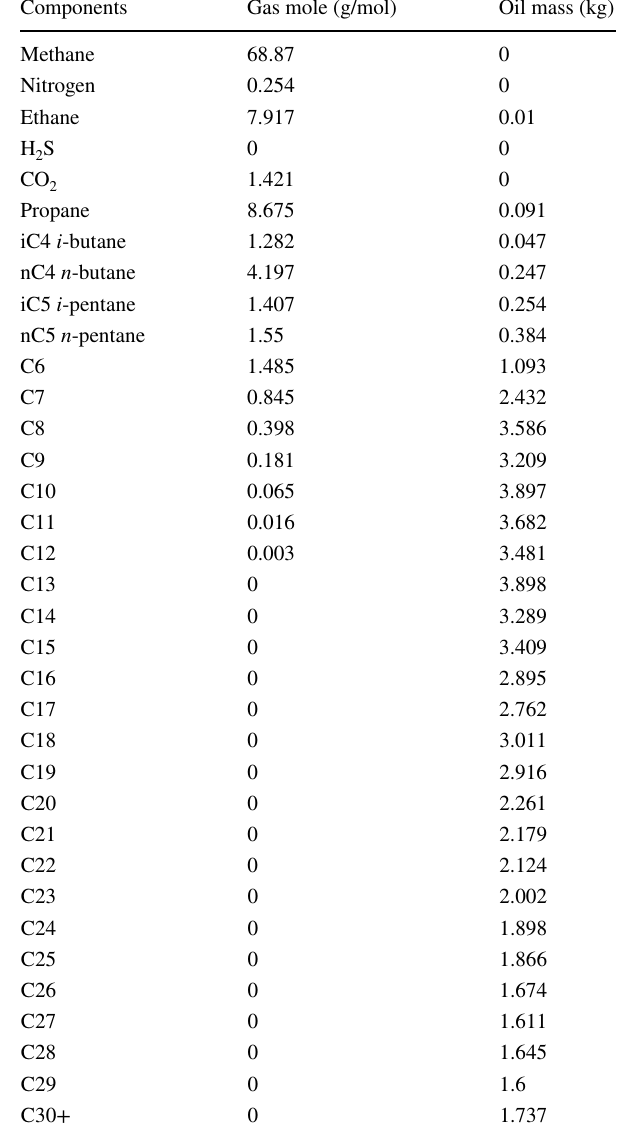
Table 1 Fluid composition of the field